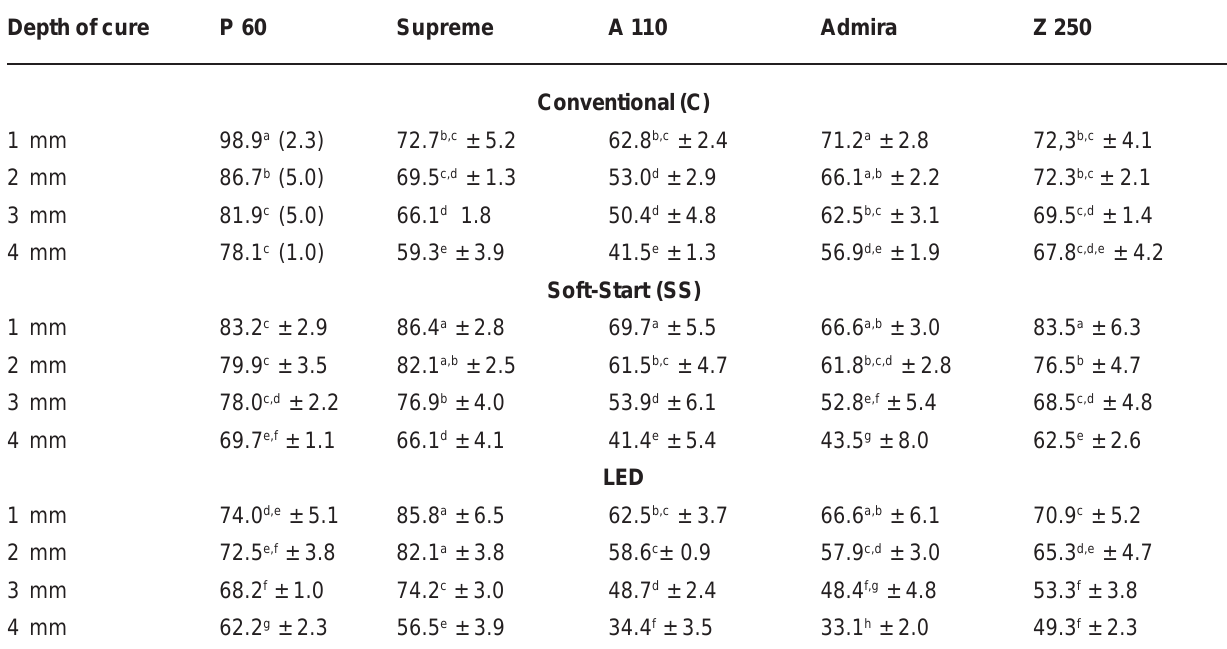
* For each composite resin, mean values with the same superscript letters are not statistically different at α =